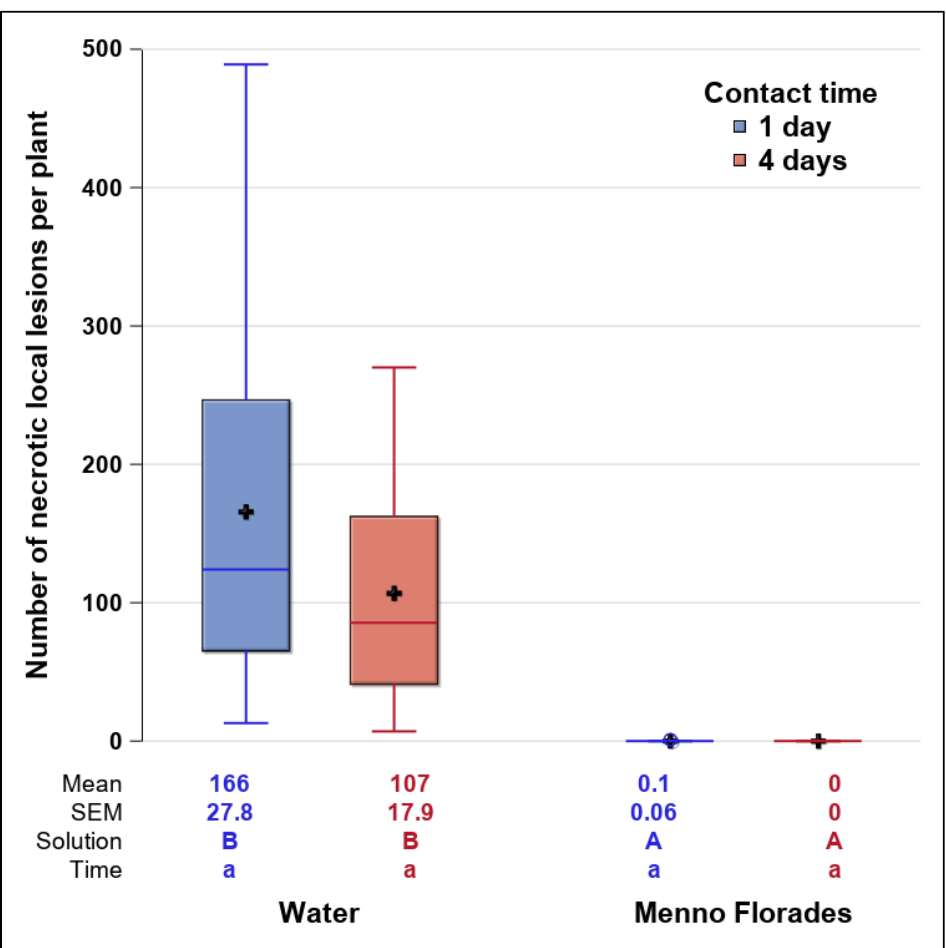
Figure 5. Efficacy of the disinfectant Menno Florades (4%, Menno-Chemie Vertriebs mbH, Norderstedt, Germany) to inactivate Tomato brown rugose fruit virus (ToBRFV)-contaminated dirt on a disinfecting mat (Flexxomat PT, Royal Brinkmann, Gravenzande, The Netherlands). ToBRFV-contaminated dirt was gained by natural contamination of the disinfection mat by scraping ToBRFV contaminated natural rubber (boot-disinfection). That dirt was incubated with Menno-Florades for 1 and 4 days, respectively. Dirt incubated with deionized water served as control. After the respective contact time, aliquots were inoculated mechanically on susceptible N. tabacum cv. Xanthi NN to determine the remaining infectiosity of the virus by counting necrotic local lesions on individual test plants. Observations are shown in a boxplot, cross inside = mean value. ‘SEM’ = Standard Error of the Mean. Letters (uppercase letters for the comparisons of solution within time levels, lowercase letters for the comparisons of time levels within solution) based on pairwise treatment comparisons using a generalized linear mixed model analysis of count data (alpha = 0.05, with Bonferroni correction). n =